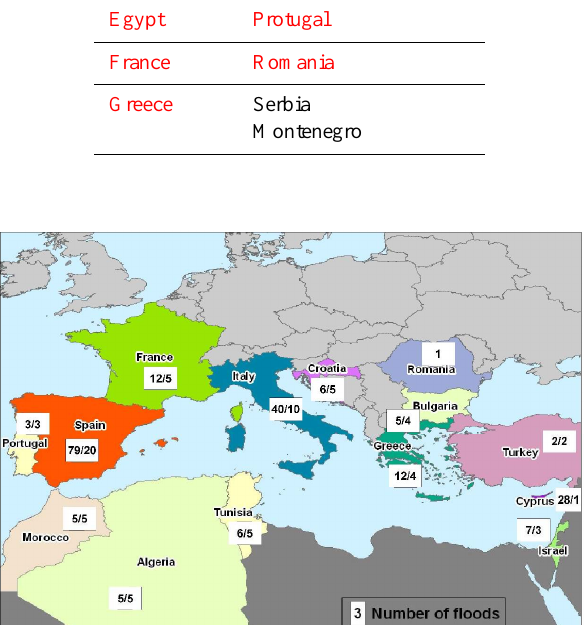
Fig. 1 . Number of flood events from 1990 till 2006 for which information is available (left number Fig. 1. Number of flood events from 1990 till 2006 for which infor- indicator). Total number of flood events selected by the MEDEX database (1996-2004) (right number mation is available (left number indicator). Total number of flood indicator). events selected by the MEDEX database (1996–2004) (right num- ber indicator).